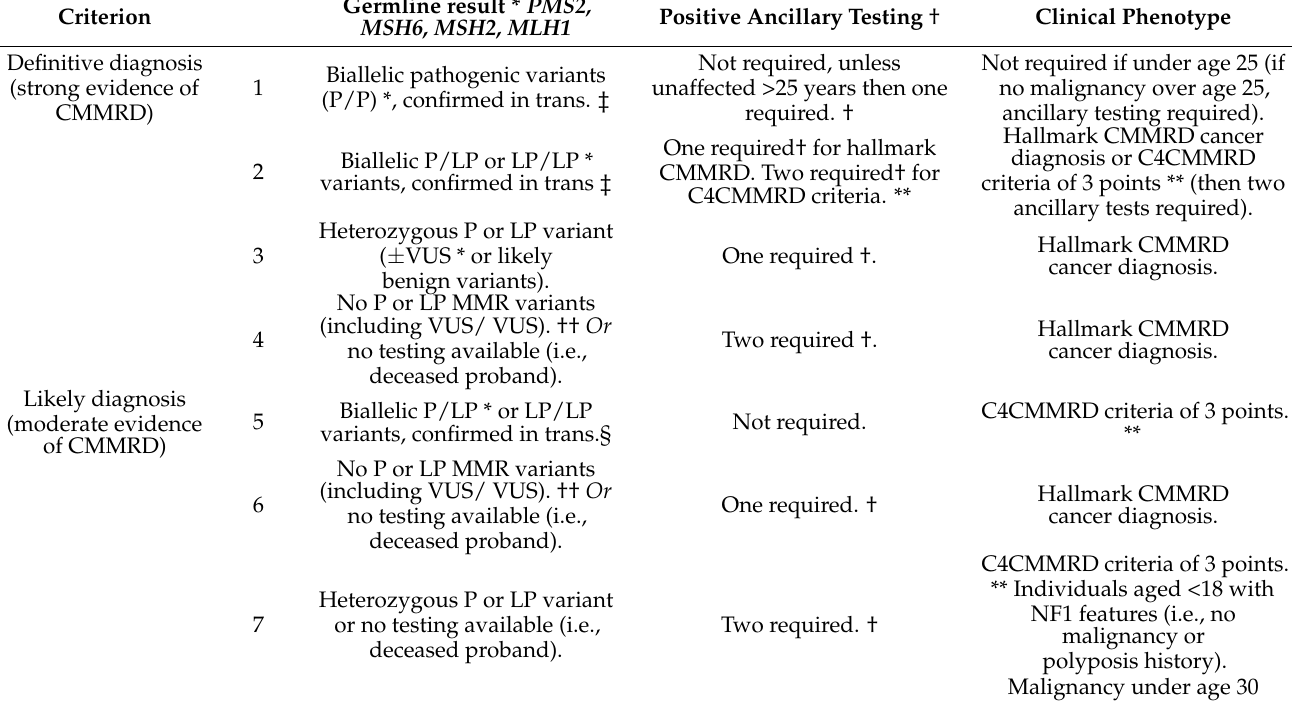
Table 2. CMMRD diagnostic